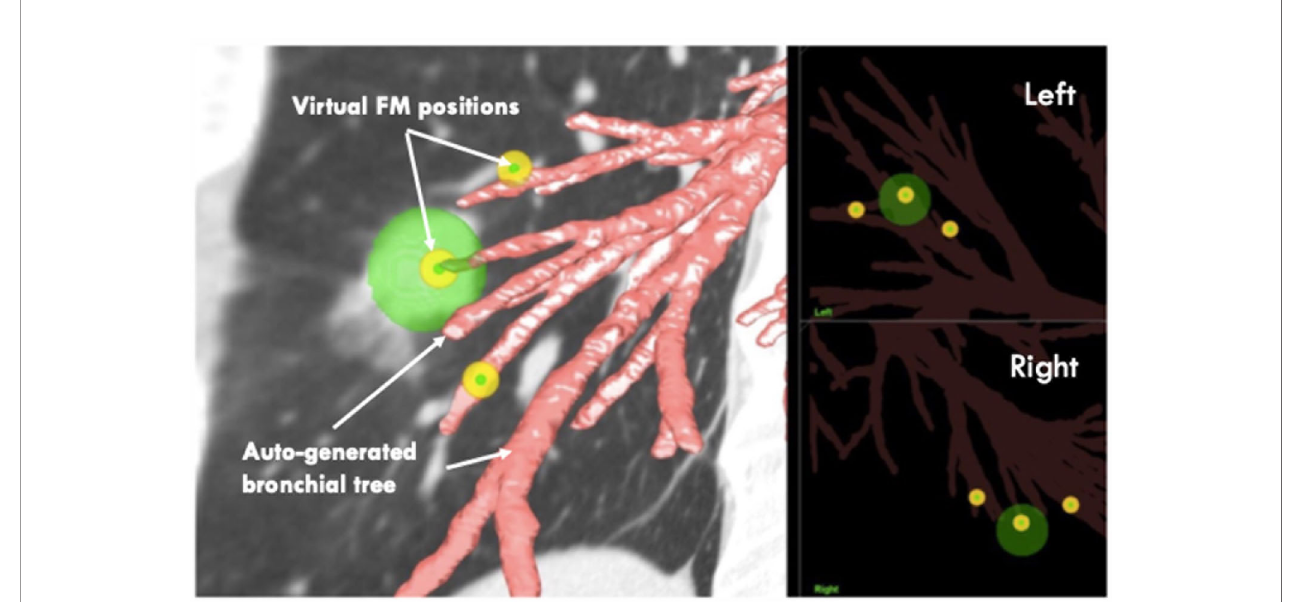
FIGURE 4 | Illustration of the autogenerated bronchial tree and the pre-planned FM positions.